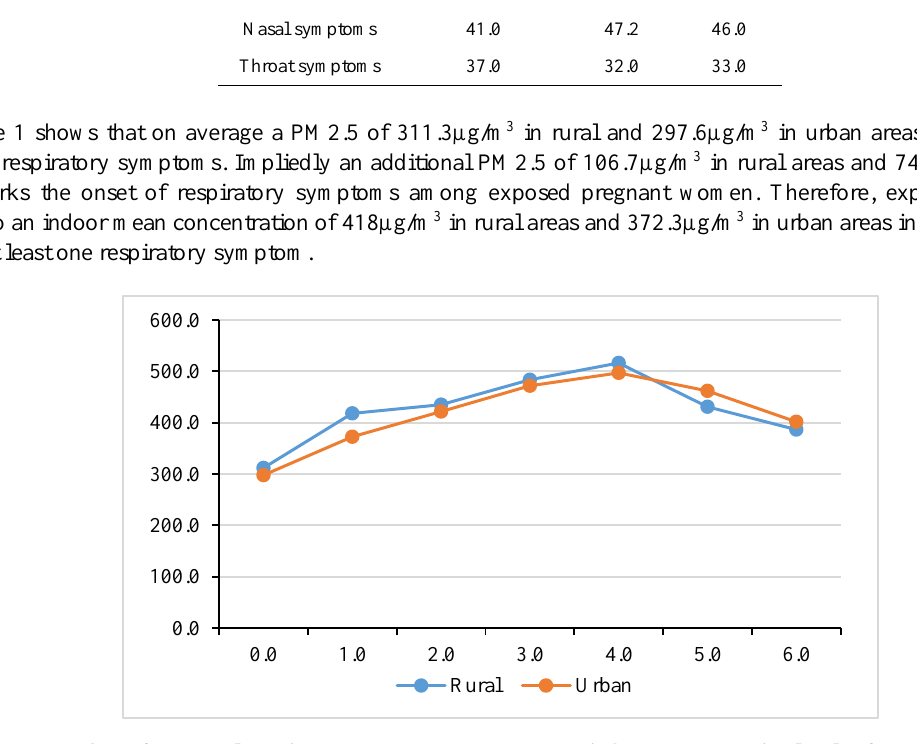
Figure 1. Number of maternal respiratory symptoms versus mean indoor concentration levels of particulate matter (micrograms) in rural and urban areas